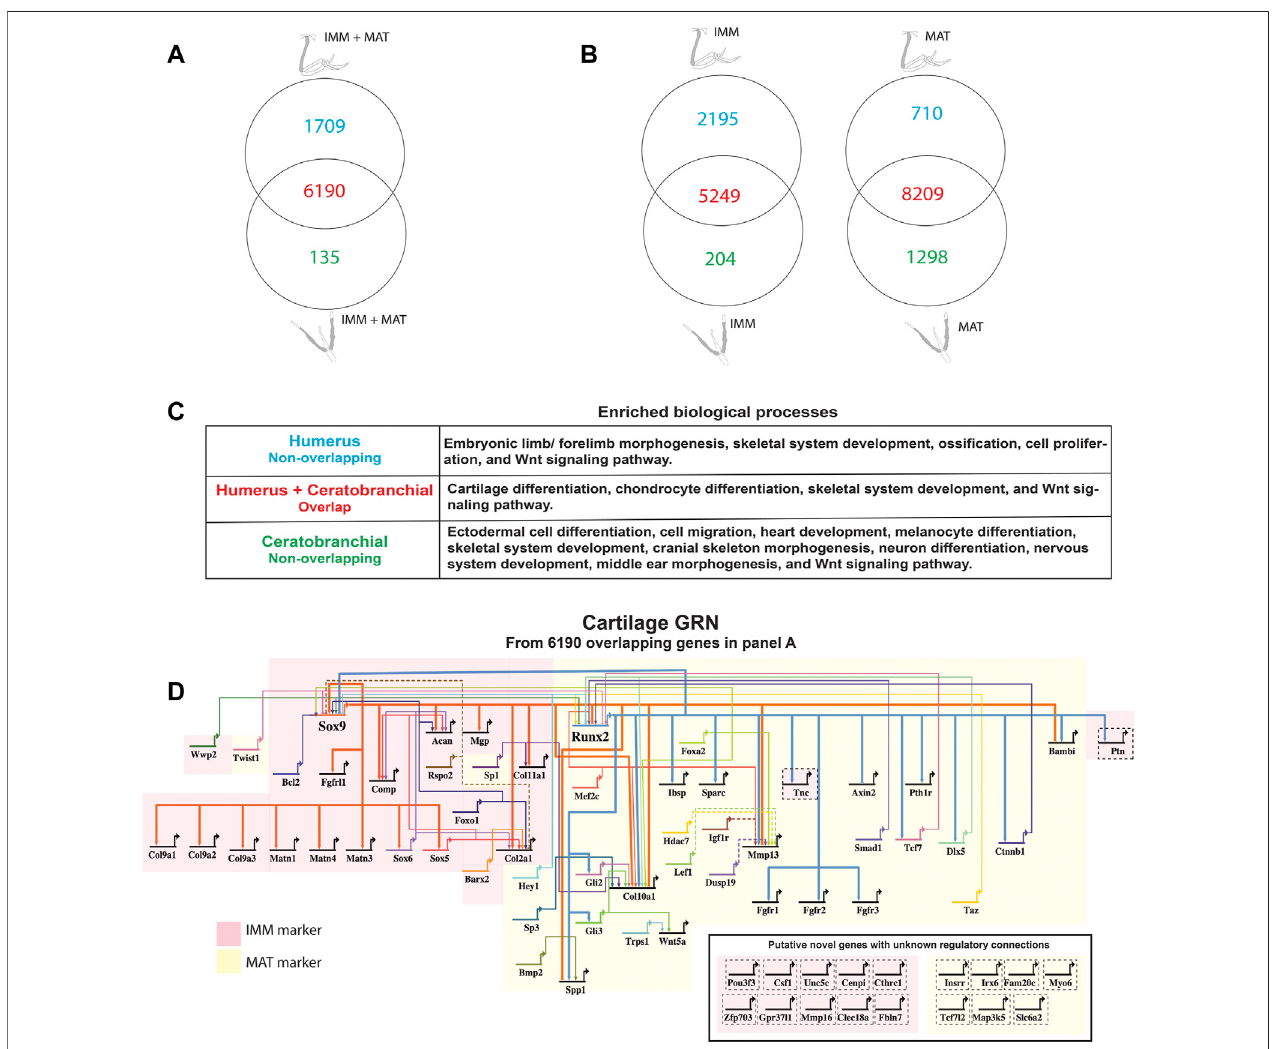
FIGURE 2 | A core GRN drives chondrocyte differentiation in the limb and head. (A) Venn diagram demonstrated that limb and head chondrocytes shared almost 80%ofthegenesexpressed abovethreshold(limbandheaddatacombinedbeforenormalizationandcutoffcalculations). (B) VenndiagramsofIMMorMAT(separately normalized) showed that limb and head chondrocytes again shared expression of most genes. (C) Enriched biological processes in the overlap of panel A included cartilage differentiation processes, whereas limb morphogenesis and neural crest-related processes were enriched in the non-overlapping humerus and ceratobranchial portions, respectively. (D) A core cartilage gene regulatory network (GRN), compiled from the overlapping portion of panel A and published literature, included typical IMM and MAT markers highlighted in pink and yellow, respectively. Arrowheads represent positive interaction, whereas negative interactions are depicted as – |. Interactions included in this network could be direct (solid lines) or indirect (dashed lines). Novel putative cartilage genes with unknown regulatory interactions were included as single-nodes surrounded by dashed lines to the bottom right of the network, except for PTN and TNC whose regulatory interactions have been con fi